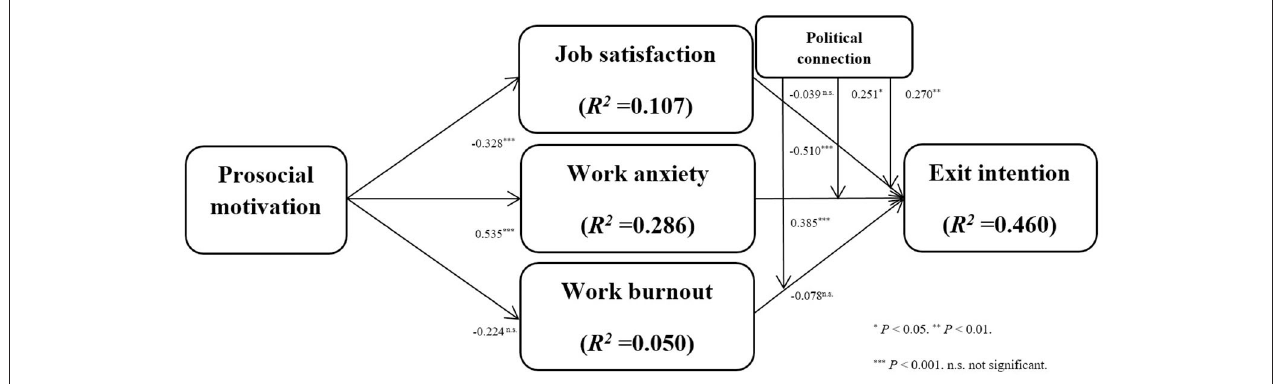
FIGURE 2 | Path coefficient and R-squares of their inner model.